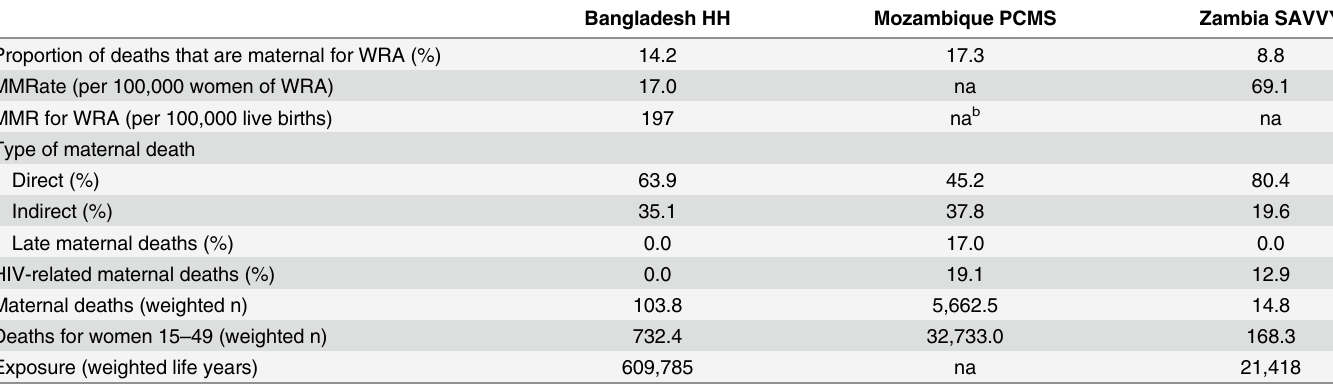
Table 3. Maternal mortality statistics by country and survey platform.